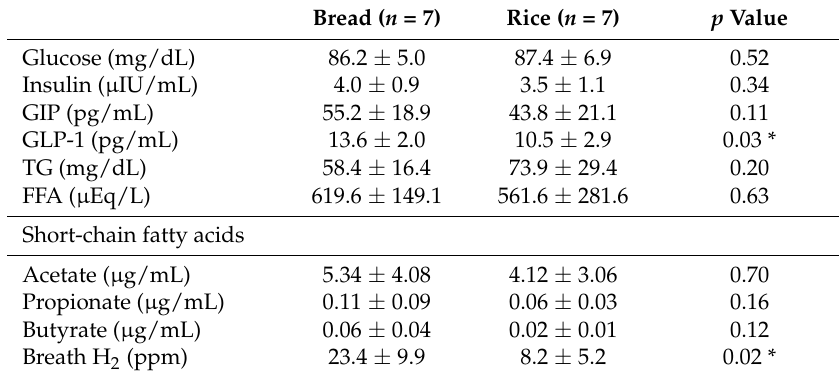
Table 4. Plasma or serum concentration of metabolites, and breath hydrogen after bread and rice